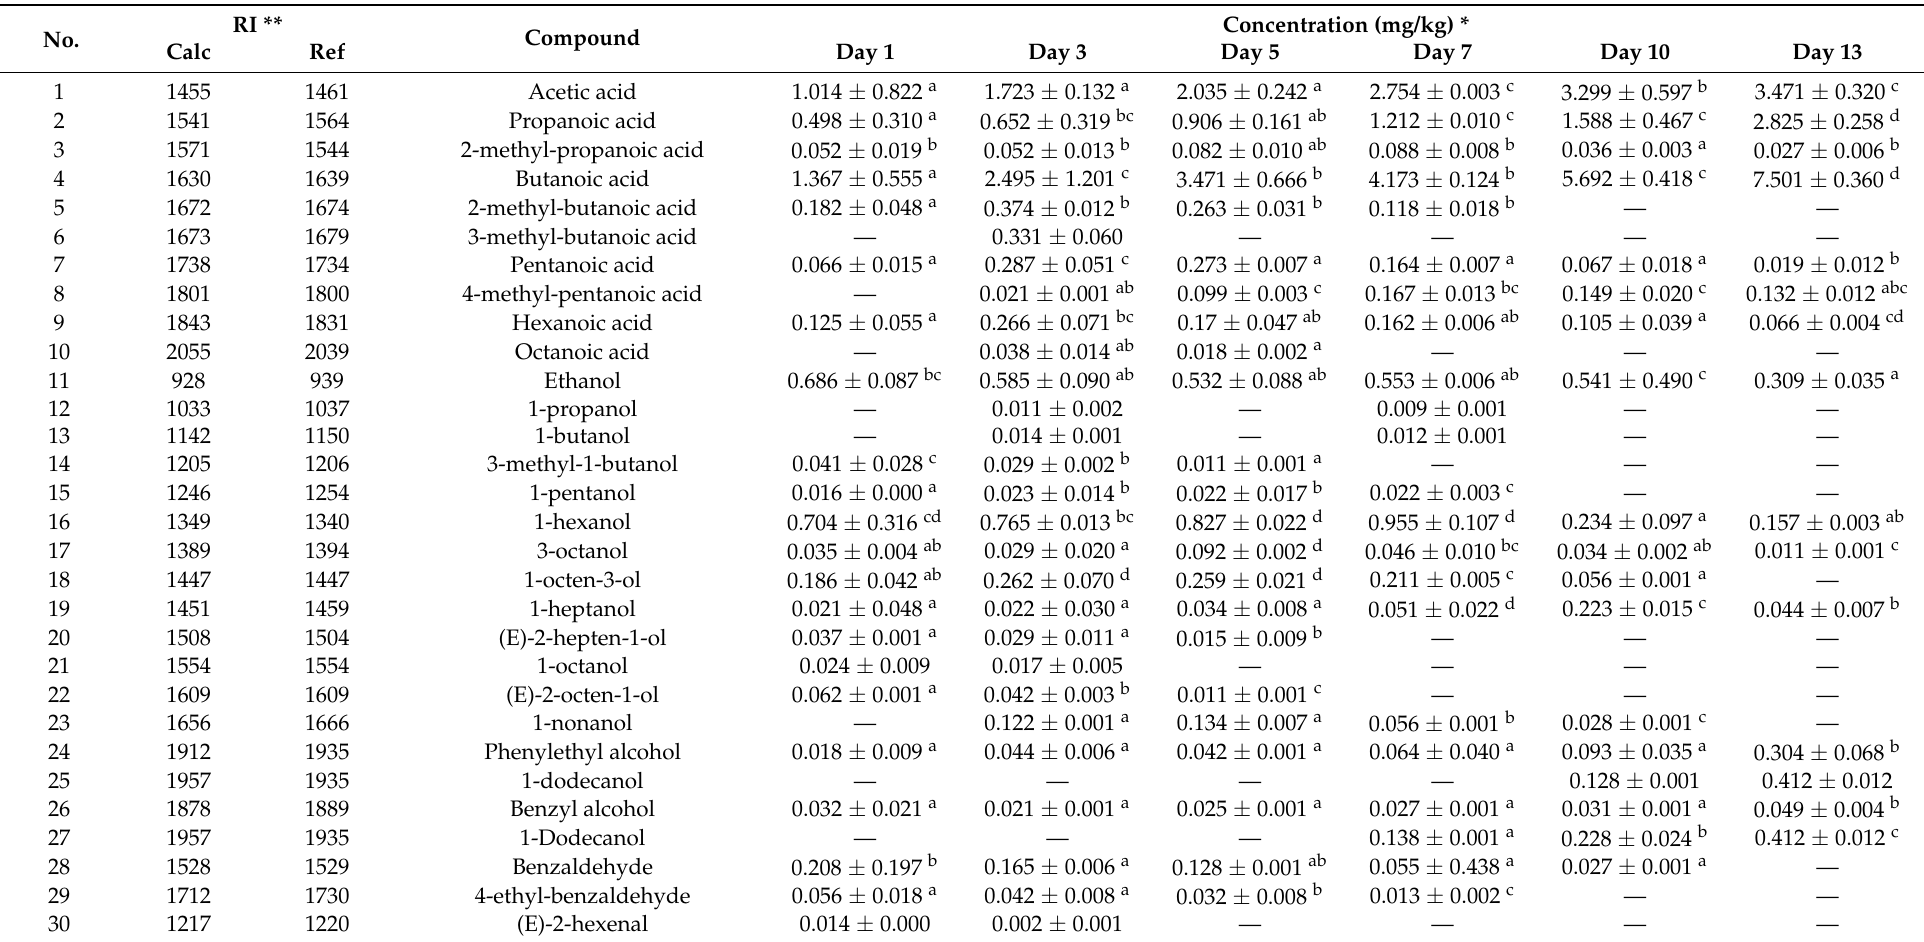
Table 2. The volatile compounds detected by GC-MS in stinky tofu during